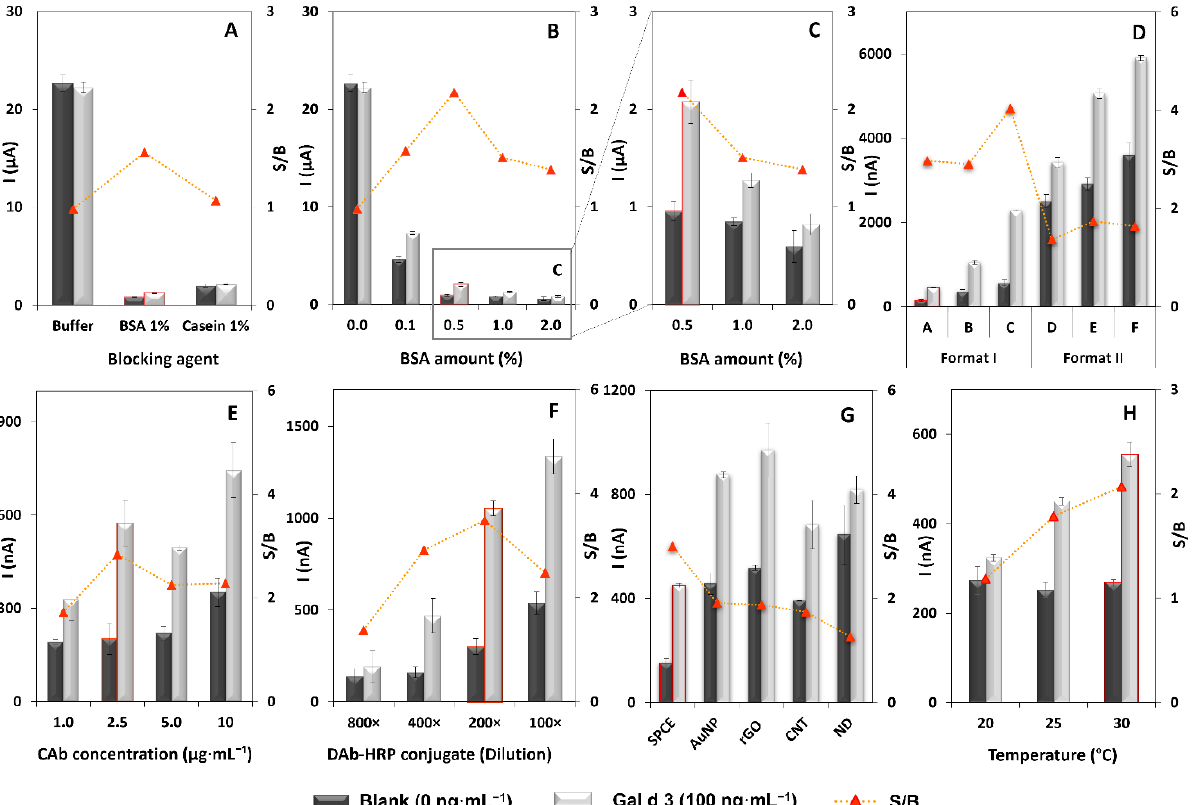
Figure 2. Optimization of the experimental parameters/variables. ( A ) Blocking agent (no blocker (buffer), BSA, and casein); ( B ) BSA amount (0.0, 0.1, 0.5, 1.0, and 2.0% (m/V)); ( C ) amplification of the best results obtained with BSA (0.5, 1.0, and 2.0% (m/V)); ( D ) assay strategy (Format I—step-by-step; Format II—previous mixing of Gal d 3 and DAb-HRP); ( E ) CAb concentration (1.0, 2.5, 5.0, and 10 µg·mL −1 ); ( F ) DAb-HRP dilution (800×, 400×, 200×, and 100×); ( G ) SPCE modification with nano- materials (bare SPCE vs. SPCE with AuNP, rGO, CNT, and ND); ( H ) temperature (20, 25, and 30 ° C). Other experimental parameters: Gal d 3: 0 ng·mL −1 (dark grey bars) and 100 ng·mL −1 (light grey bars); error bars correspond to the standard deviation of three replicates.